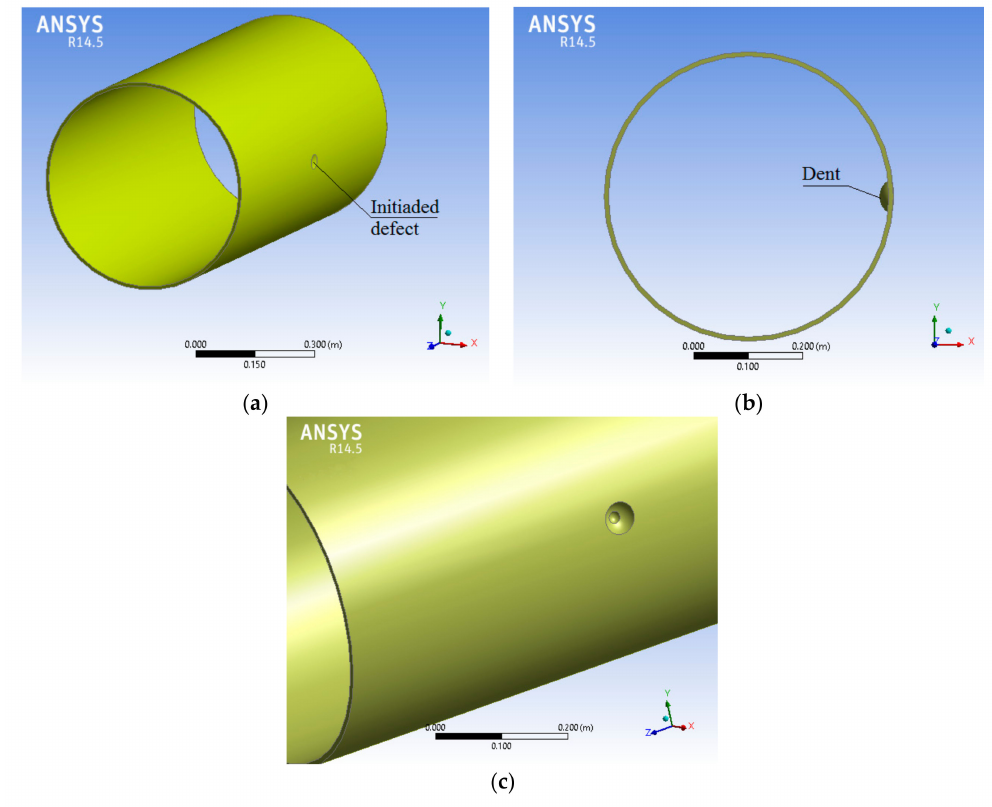
Figure 7. The model of the pipe with the initiated combined defects: ( a ) denotes a pipe with a gouge defect; ( b ) is a pipe with a dent; ( c ) is a pipe with a combined